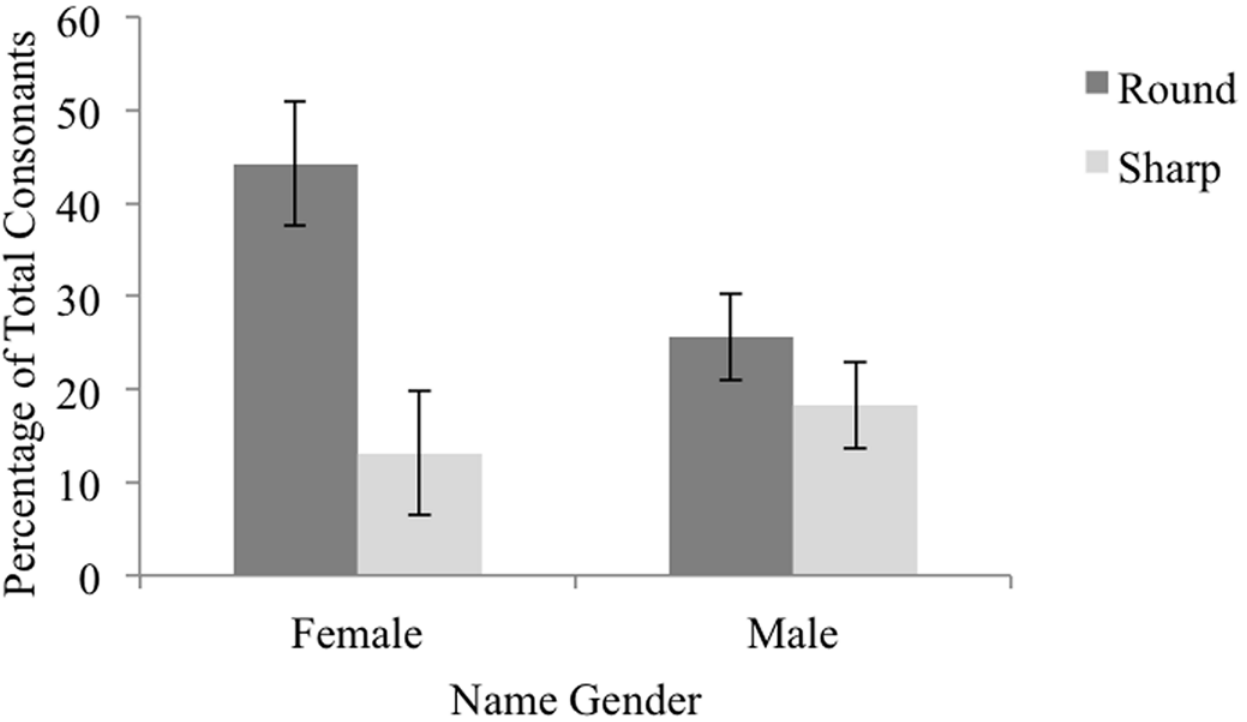
Fig 3. Percentage of Round-Sounding and Sharp-Sounding Consonants in Typical Names. The percentage of round-sounding and sharp-sounding consonant phonemes within either typical female or male names. Error bars reflect 95% confidence intervals computed using the method outlined by Cousineau [31] to remove between-item